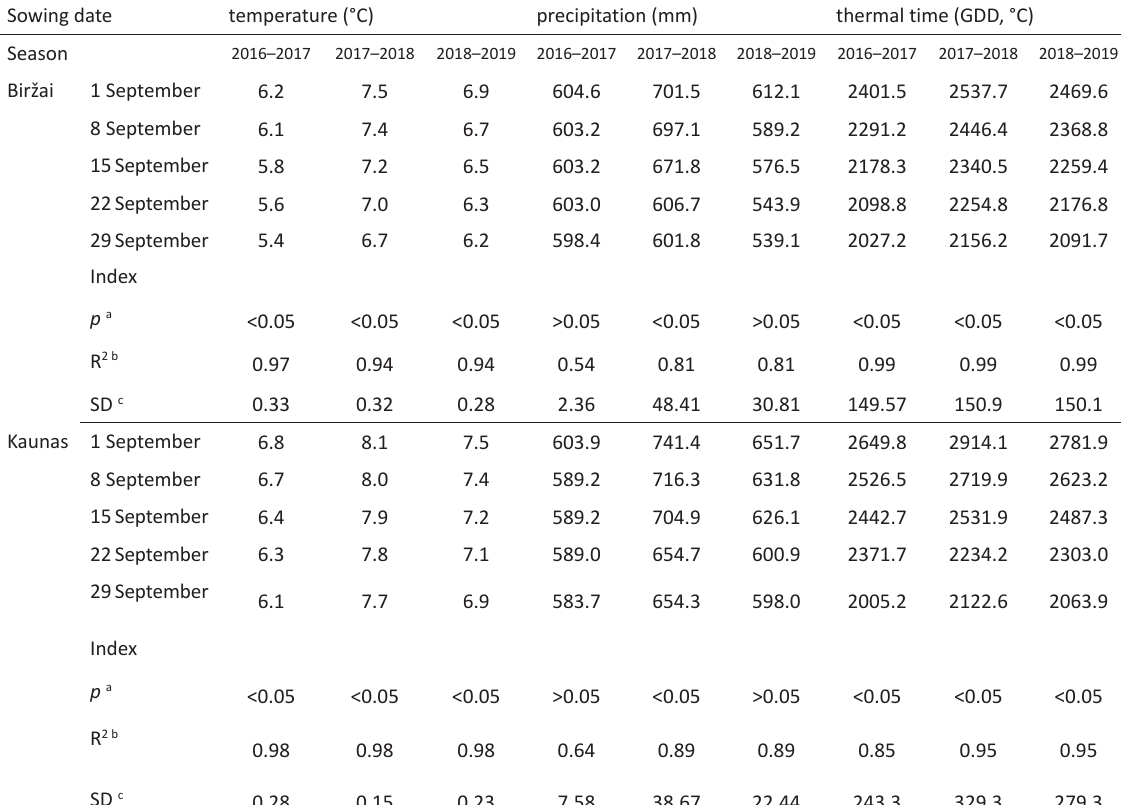
Table 1. Observed mean vegetation period (sowing to maturity) temperature (°C), precipitation (mm) and thermal time (growing degree days, °C) at different sowing dates for three growing seasons, shown together with a confidence level ( p ), coefficient of determination (R 2 ) and standard deviation (SD) when one season values are compared to two other seasons.